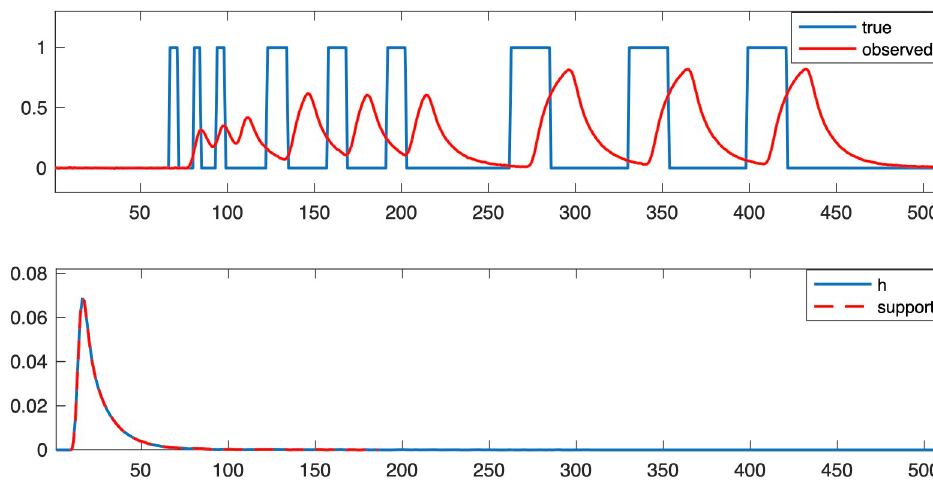
Fig 4. Simulated problem setup. The true signal and simulated observation with noise level 0.5% are provided in the top plot, and the impulse response function and its support are provided in the bottom plot.